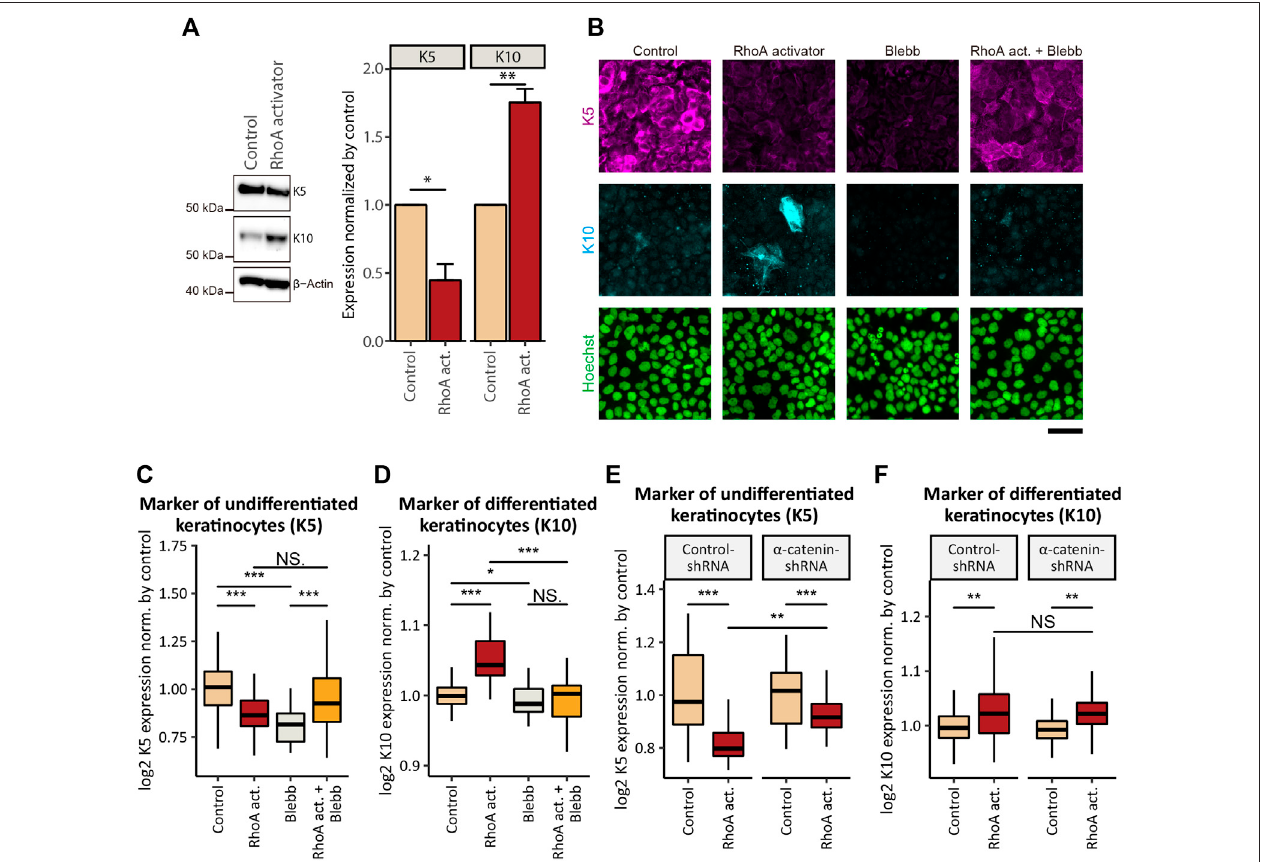
FIGURE 6 | Activation of actomyosin contractility induces epidermal differentiation of cSCC cells. (A) Whole-cell lysates of con fl uent A431 cells treated with or without 5 μ g/ml RhoA activator (RhoA act.) for 24 h were immunoblotted for K5, K10, and β -actin. Bar graphs show the result of the densitometric quanti fi cation of K5 and K10. Values were normalized with the mean values in control cells. Each bar represents mean ± SD. n (cid:1) 3 independent experiments. * p < 0.05; ** p < 0.01. (B) Con fl uent A431 cells treated with 5 μ g/ml RhoA activator (RhoA act.), 100 μ M p -aminoblebbistatin (Blebb) or combination of both drugs (RhoA act. + Blebb) for 24 h were stained for markers of basal (undifferentiated, K5, magenta) and suprabasal (differentiated, K10, cyan) keratinocytes. Cell nuclei were labeled with Hoechst 33342(green).Scalebar,50 μ m. (C,D) Quanti fi cationof (B) .FluorescenceintensitiesofK5 (C) andK10 (D) incon fl uentA431cellstreatedwithindicatedcompoundsfor 24 h. Values were normalized with the mean values in control cells. Box-and-whisker plots show the median, the interquartile range, and the tenth and ninetieth percentiles. n (cid:1) 60 fi elds of view from three independent experiments were pooled for the analysis. * p < 0.05; *** p < 0.001; NS, p > 0.05. (E, F) Quanti fi cation of fl uorescence intensities of K5 (E) and K10 (F) in con fl uent A431cells expressing control-shRNA or α -catenin-shRNA treated with indicated compounds for 24 h. Values were normalized with the mean values in non-treated controls. Box-and-whisker plots show the median, the interquartile range, and the tenth and ninetieth percentiles. n (cid:1) 60 fi elds of view from three independent experiments were pooled for the analysis. ** p < 0.01; *** p < 0.001; NS, p > 0.05.